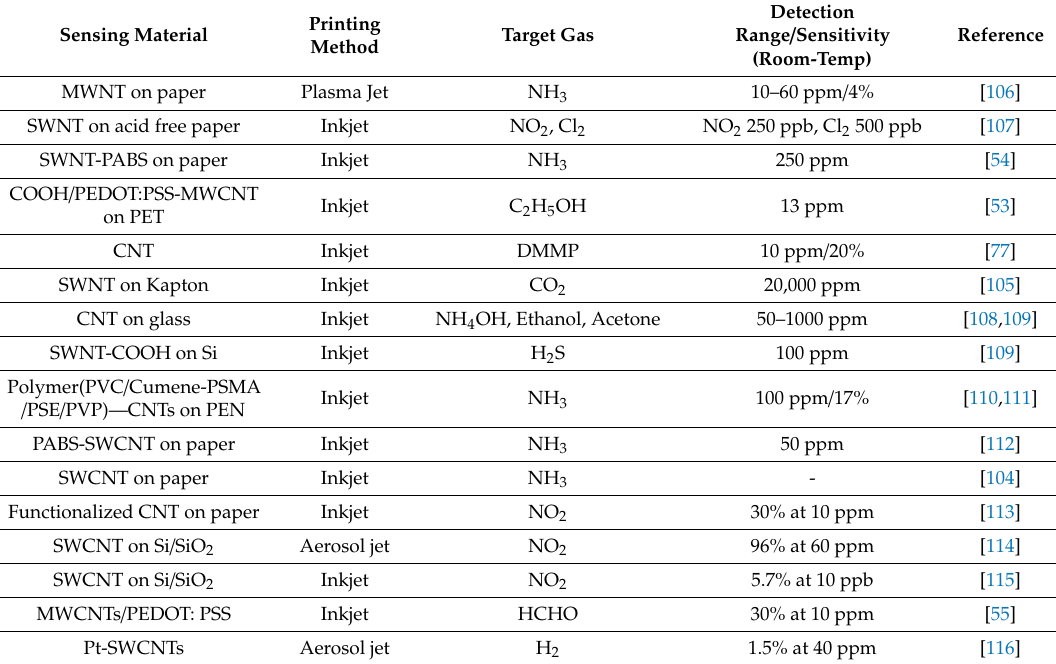
Table 2. Printed carbon nanotube (CNT) gas